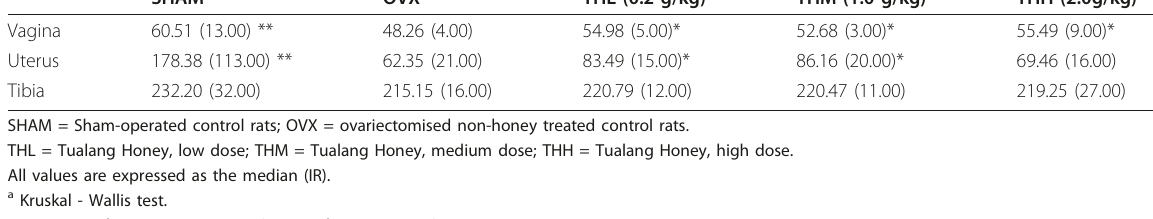
Table 1 Effects of Tualang honey on relative organ weight (mg/g body weight) after 2 weeks administration